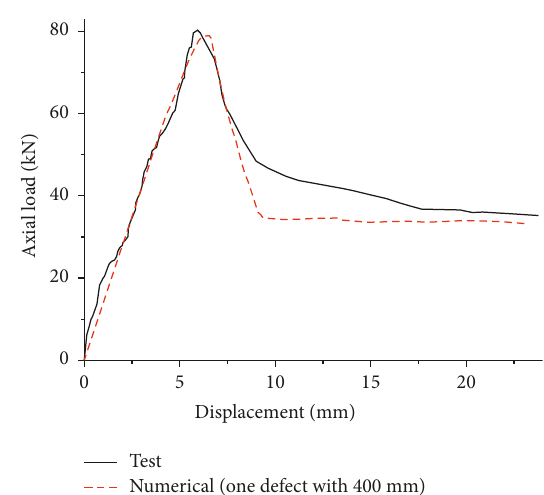
Figure 2: The relationship of axial load and displacement of rock